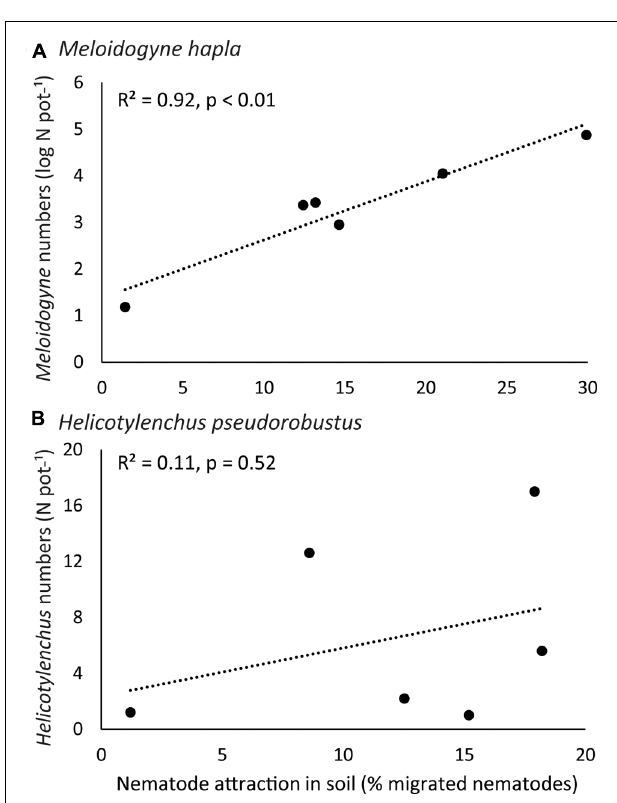
FIGURE 3 | Correlation plots between nematode attraction ( x -axis) and nematode reproduction ( y -axis), for root-feeding nematodes (A) Meloidogyne hapla and (B) H. pseudorobustus . Dots represent the six different plant species tested. R 2 -values and p -values of the Pearson correlation tests are